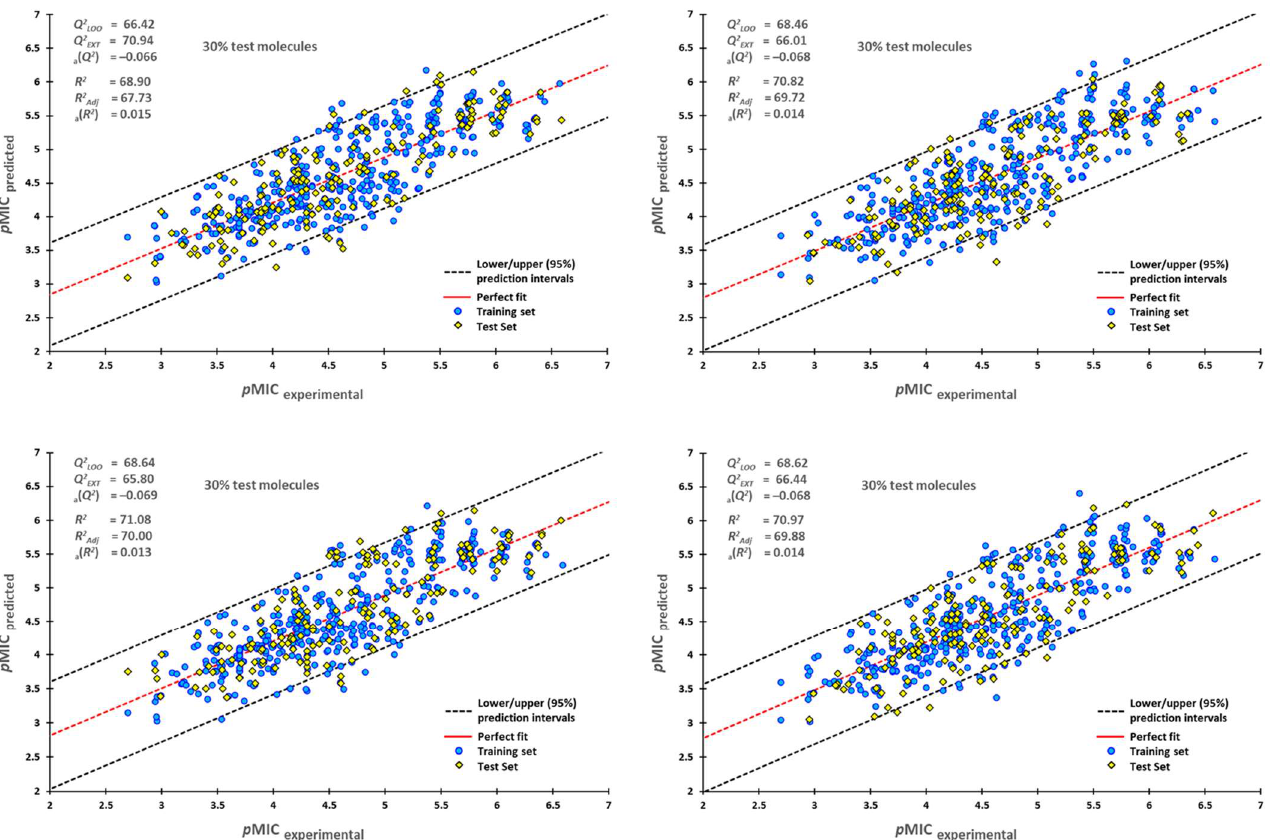
Figure 1. Scatterplots of predicted p MIC against experimental p MIC values. Blue dots represent molecules of the training set (70%), and yellow diamonds depict molecules used for the test set (30%). For each plot, the percentage of molecules used in the training and test datasets were randomly